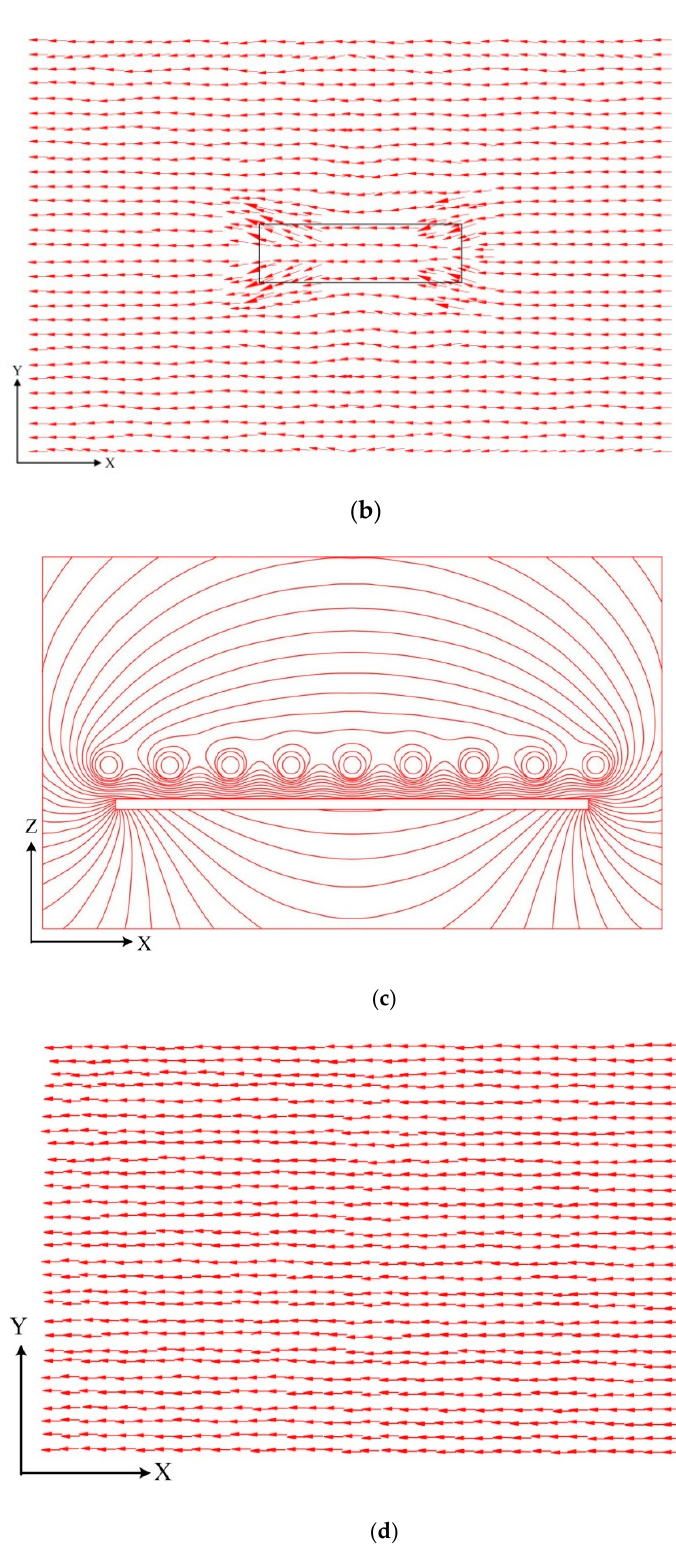
Figure 6. A schematic diagram of the magnetic flux path in two planes with/without a magnetizer piece. ( a ) X–Z plane (cross section of the coils); ( b ) X–Y plane (steel blank surface, the magnetizer depicted as the black frame); ( c ) X–Z plane without magnetizer piece; and ( d ) X–Y plane without magnetizer piece.